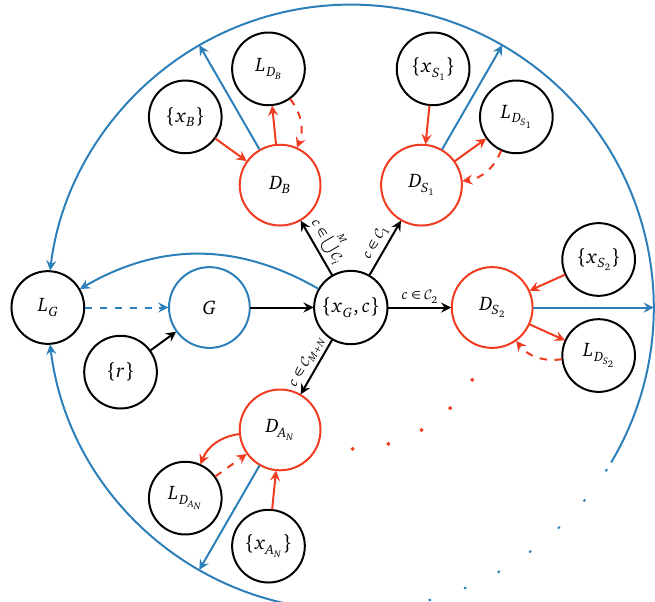
Figure 4: Structure of our general subtraction and addition GAN. The input { r } de- scribes a batch of random numbers and { x } the true input data or generated batches. The label c encodes the category of the generated events. Blue arrows indicate the generator training, red arrows the discriminators training.